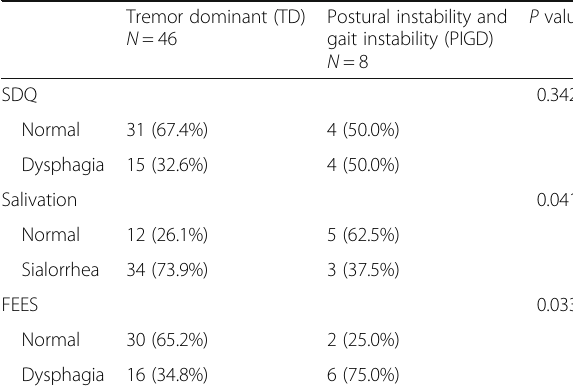
Table 4 Dysphagia in relation to different phenotypes of